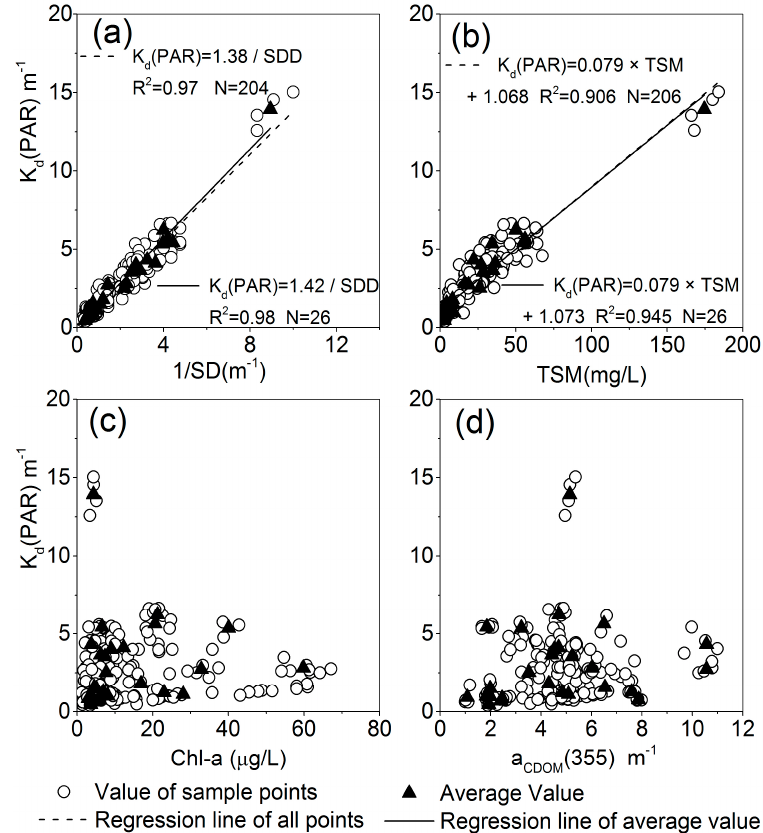
Figure 2. Correlation between K d (PAR) and the concentration of the water’s quality parameters: ( a ) water transparency (SDD); ( b ) total suspended matter (TSM); ( c ) chlorophyll- a (Chl- a ); and ( d ) absorption coefficient of chromophroic dissolved organic matter (CDOM) at 355 nm (a CDOM (355)).